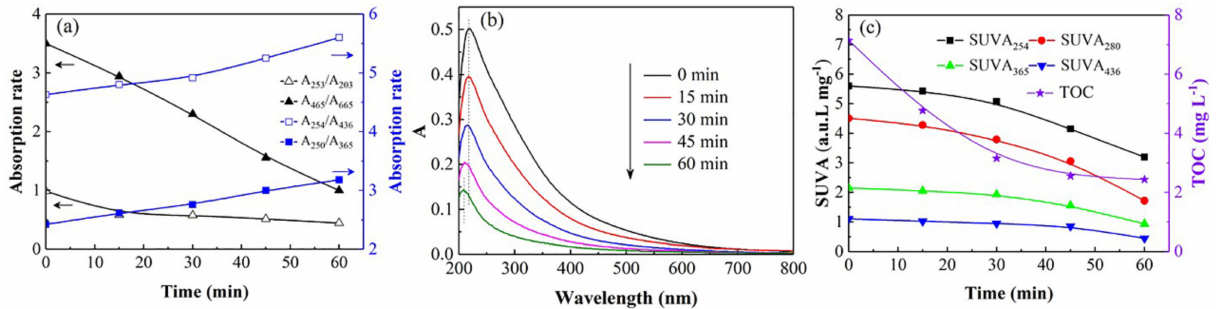
Figure 5. ( a ) UV absorption rate; ( b ) UV-vi spectrum; ( c ) SUVA x and TOC concentration for HA decomposition. [HA] 0 = 10 mg L − 1 , [SPB] 0 = 1 mmol L − 1 , pH =